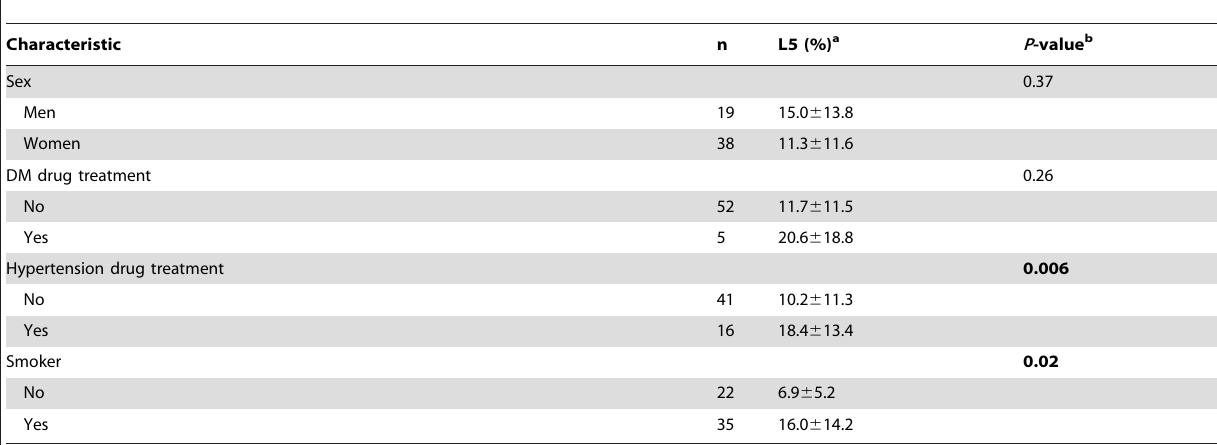
Table 3. Comparison of L5% in subjects grouped according to characteristics.